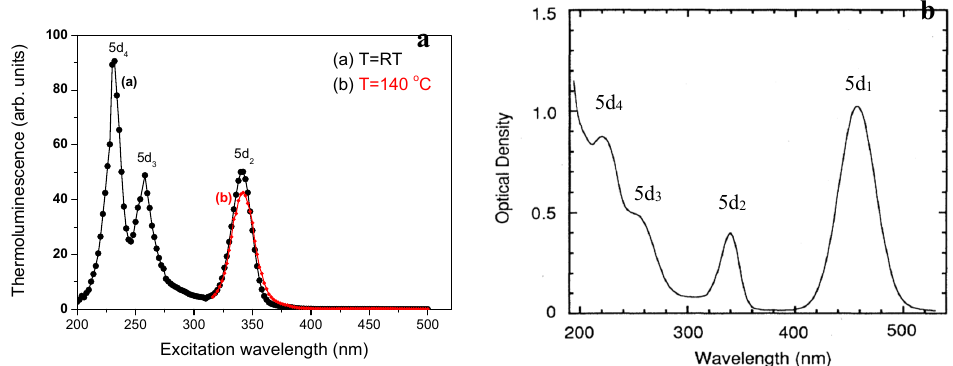
Figure 8. Thermoluminescent excitation spectrum ( a from You et al. [72]) and optical absorption spectrum ( b , adopted from Hamilton et al. [73]) of YAG:Ce 3+ . Note the absence in the 5d 1 band in the TLES spectrum.